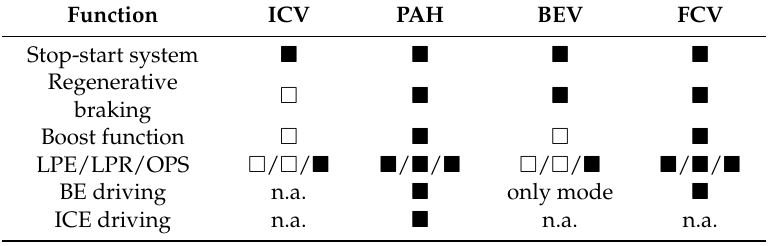
Table 8. Functionalities of vehicle concepts analyzed. Pure internal combustion engine (ICE) driving, point shift (OPS) are chosen in this work as the names of functions and are adapted from Hofmann [42]. Function